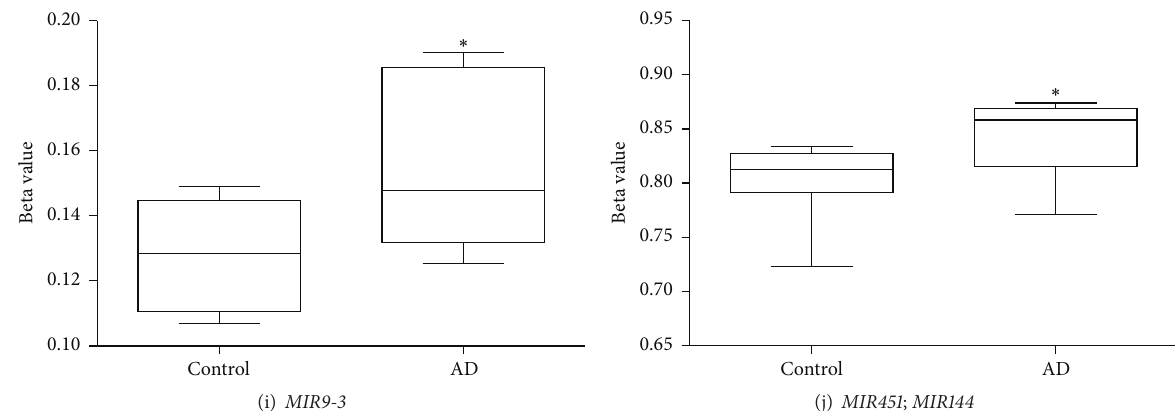
Figure 2: Box plots of DNA methylation level of microRNA genes found to be hypermethylated in Alzheimer’s disease brains. The 10 hypermethylated CpG sites encompassing microRNA genes are presented (a–j). Mann-Whitney test, ∗∗ 𝑝 < 0.01 , ∗ 𝑝 < 0.05 . Beta values are displayed as means ± SEM.